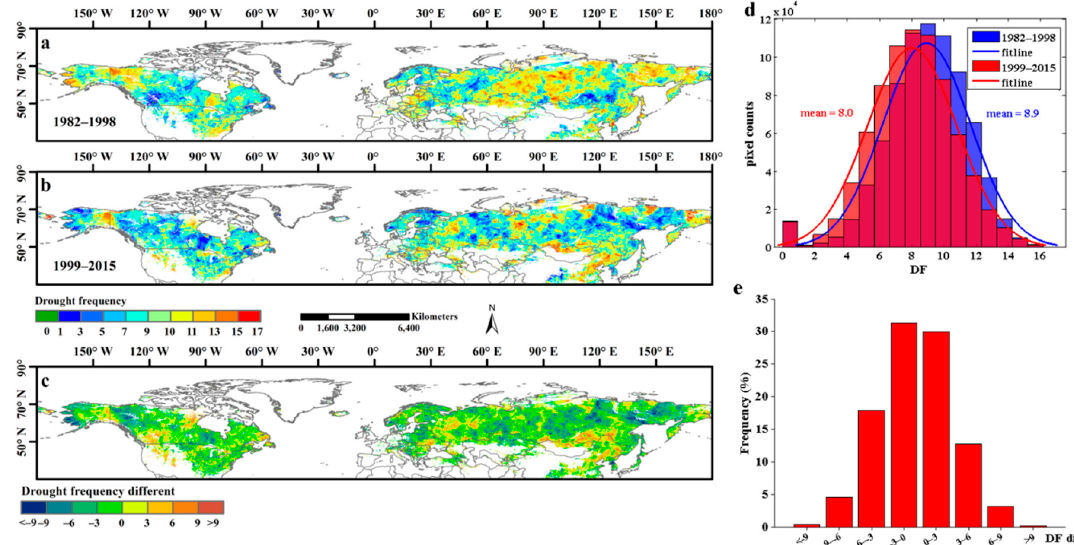
Figure 8. The spatial distribution of drought frequency (DF) of each pixel in Northern Hemisphere